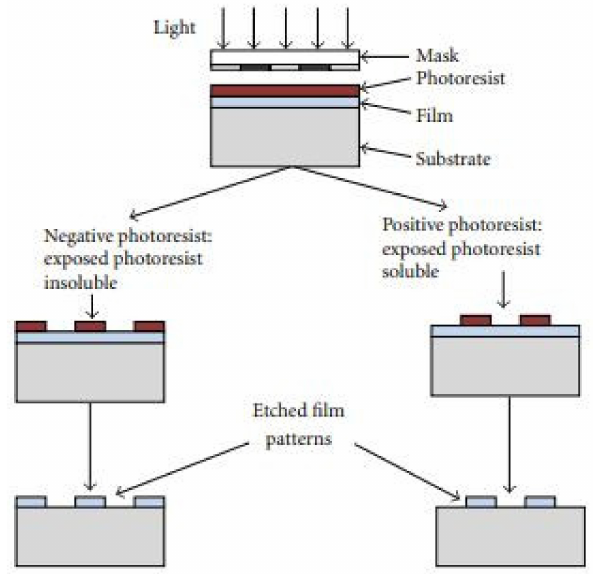
Figure 5. Positive and negative photoresist [133]. (Adapted from from Ref.